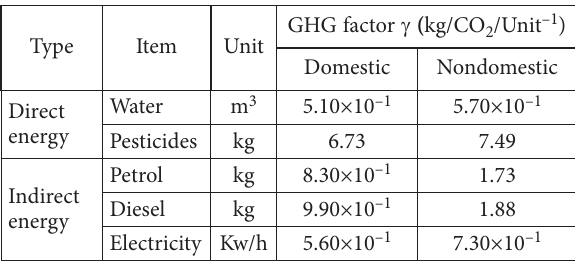
Table 4. GHG factors of the upstream energy inputs (National Standardization Administration, 2021; Integrated Knowledge for our Environment,